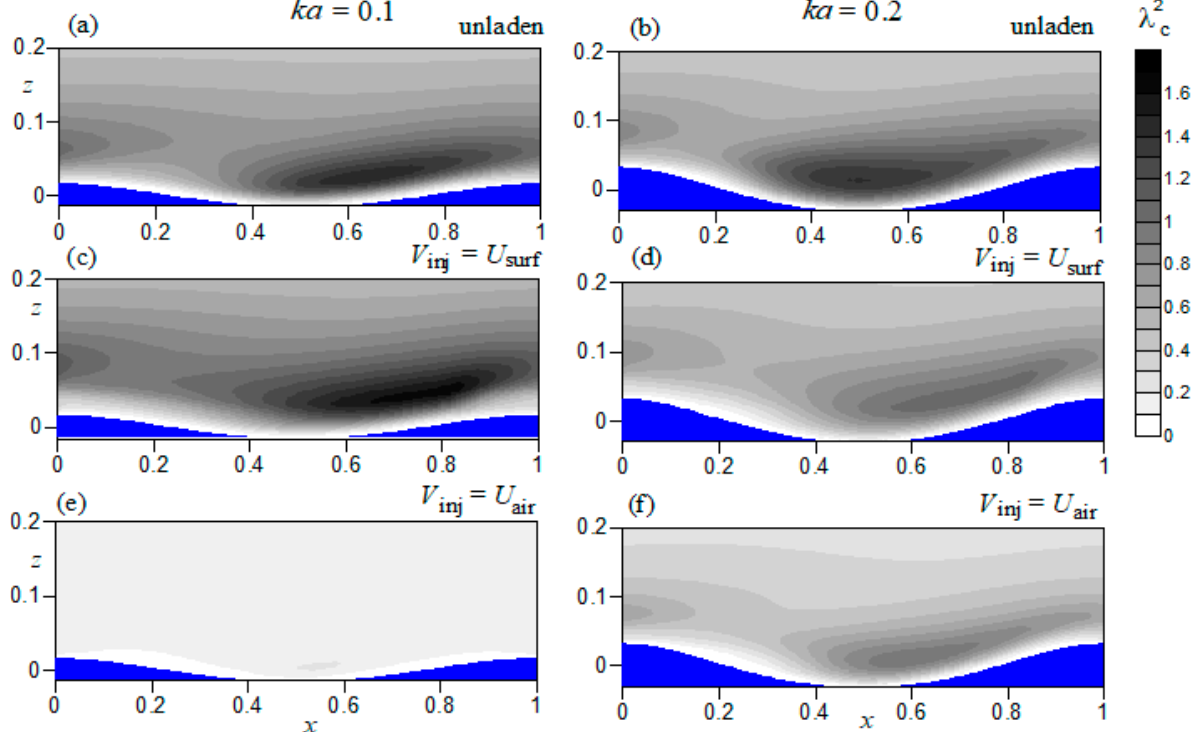
Figure 5. Phase-averaged swirling strength, λ 2 c , obtained for different wave steepness ( ka = 0.1, left and ka = 0.2, right) and droplet-free (panels a , b ) and droplet laden flows with different injection scenario ( V inj = U surf , (panels c , d ), and V inj = U air , panels e , f ). On the other hand, for wave steepness ka = 0.2 (Figure 8d), the effects of acceler- ation/deceleration of the wind by the droplets are quantitatively less pronounced, as compared to the case ka = 0.1. The stresses and the swirl are also reduced significantly (by about 30%) by droplets with V inj = U air as compared to the droplet-free flow (Figure 8e,f). However, for this wave steepness, ka = 0.2, the stresses are not enhanced by the droplets injected with the surface wave velocity ( V inj = U surf ) as is observed in simulations with steepness ka = 0.1 (Figure 8b), whereas the swirling strength is reduced by about 30% as compared to the droplet-free flow (Figure